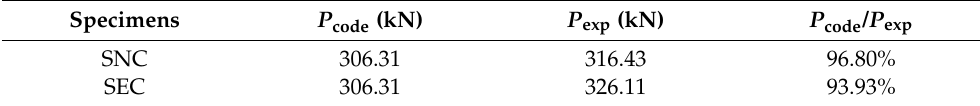
Table 4. Comparison of calculated and experimental bearing capacity.